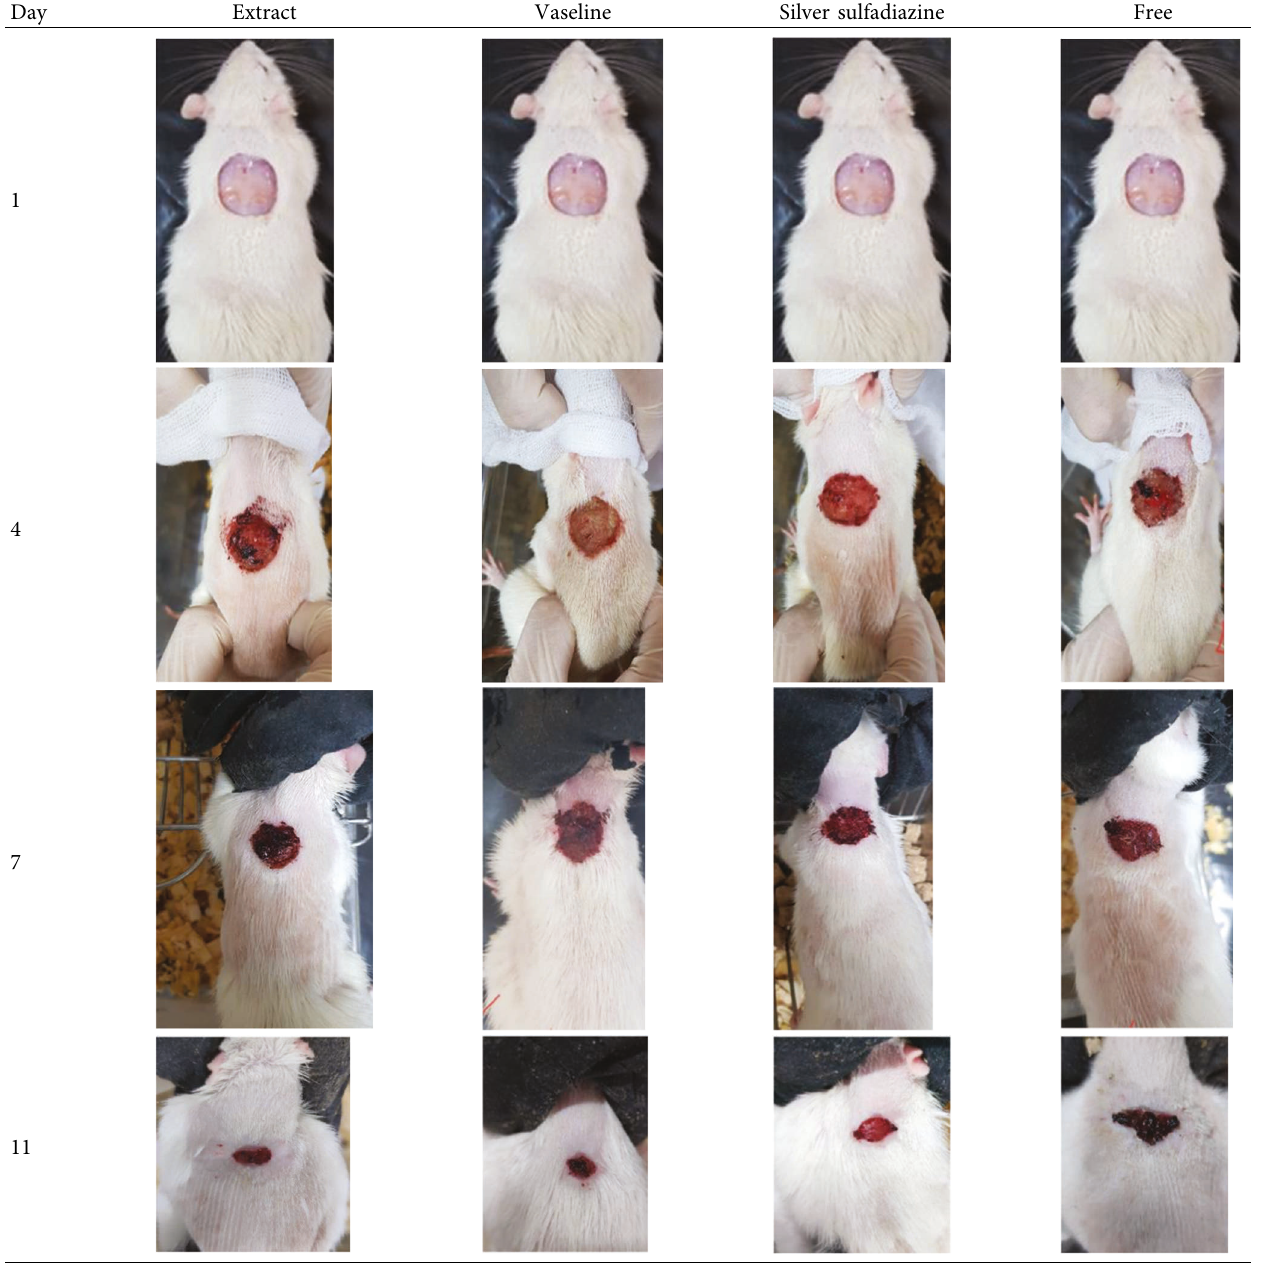
Table 6: Regarding wound analysis, groups were treated with extract, Vaseline, and silver sulfadiazine, and the free group did not receive anything on days 1, 4, 7, 11, 14, and